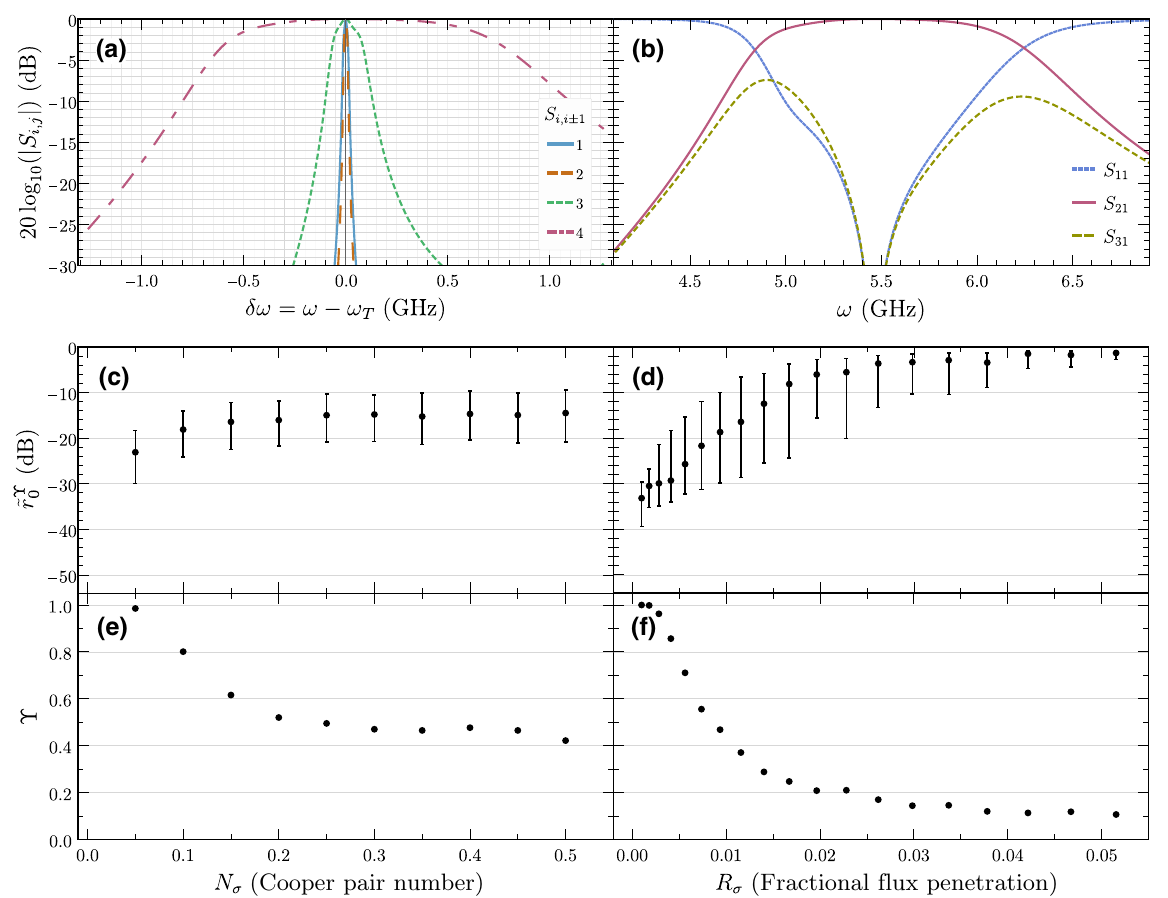
FIG. 5. (a) Comparison of the normalized output power at the i th port given input at the ( i ± 1)th port for each set of external circuit parameters shown in Table I. For the first, second, and fourth points, the transmission direction is such that | S i , i − 1 | 2 is plotted. For the second point, | S i , i + 1 | 2 is plotted. (b) Comparison of normalized output powers at each port assuming input at port 1. At ω ≈ 5.46 GHz we observe full transmission in a clockwise fashion to the second port, with zero transmission in the opposite direction, indicative of circulator behavior. The parameters and offset charge used are the same as in Fig. 4. External circuit parameters are set according (defined in Appendix D 1 as the extinction ratio for devices with less than to the fourth point, shown in Table I. The median of r ϒ 0 , is plotted as a function of the standard deviation of (c) the charge noise distribution N σ and (d) R σ , the 1 dB of insertion loss), ˜ r ϒ 0 for distribution of fractional flux penetration per loop. Error bars indicate the spread from the first quartile to the third quartile of r ϒ 0 each value of N σ and R σ . Device yield ϒ (defined in Appendix D 1 as the fraction of devices with less than 1 dB of insertion loss) is plotted as a function of (e) N σ and (f) R σ . The parameters for ideal tuning in plots (c),(f) are the same as in